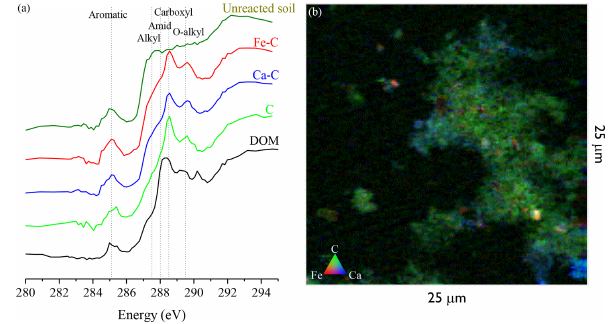
Figure 6. JRB soil reacted with DOM under continuously wet con- ditions. (a) C NEXAFS spectra extracted from C, Ca and Fe regions of STXM map. Spectra of unreacted soil (top) and DOM solution (bottom) are presented. Dashed vertical lines point out C species. (b) Tri-colored STXM map of fine fraction from JRB soil reacted four times with DOM during the continuously wet treatment. Fe (red), Ca (blue) and C (green). Image size 25µm × 25µm. For color rendering of this image please refer to the online version.